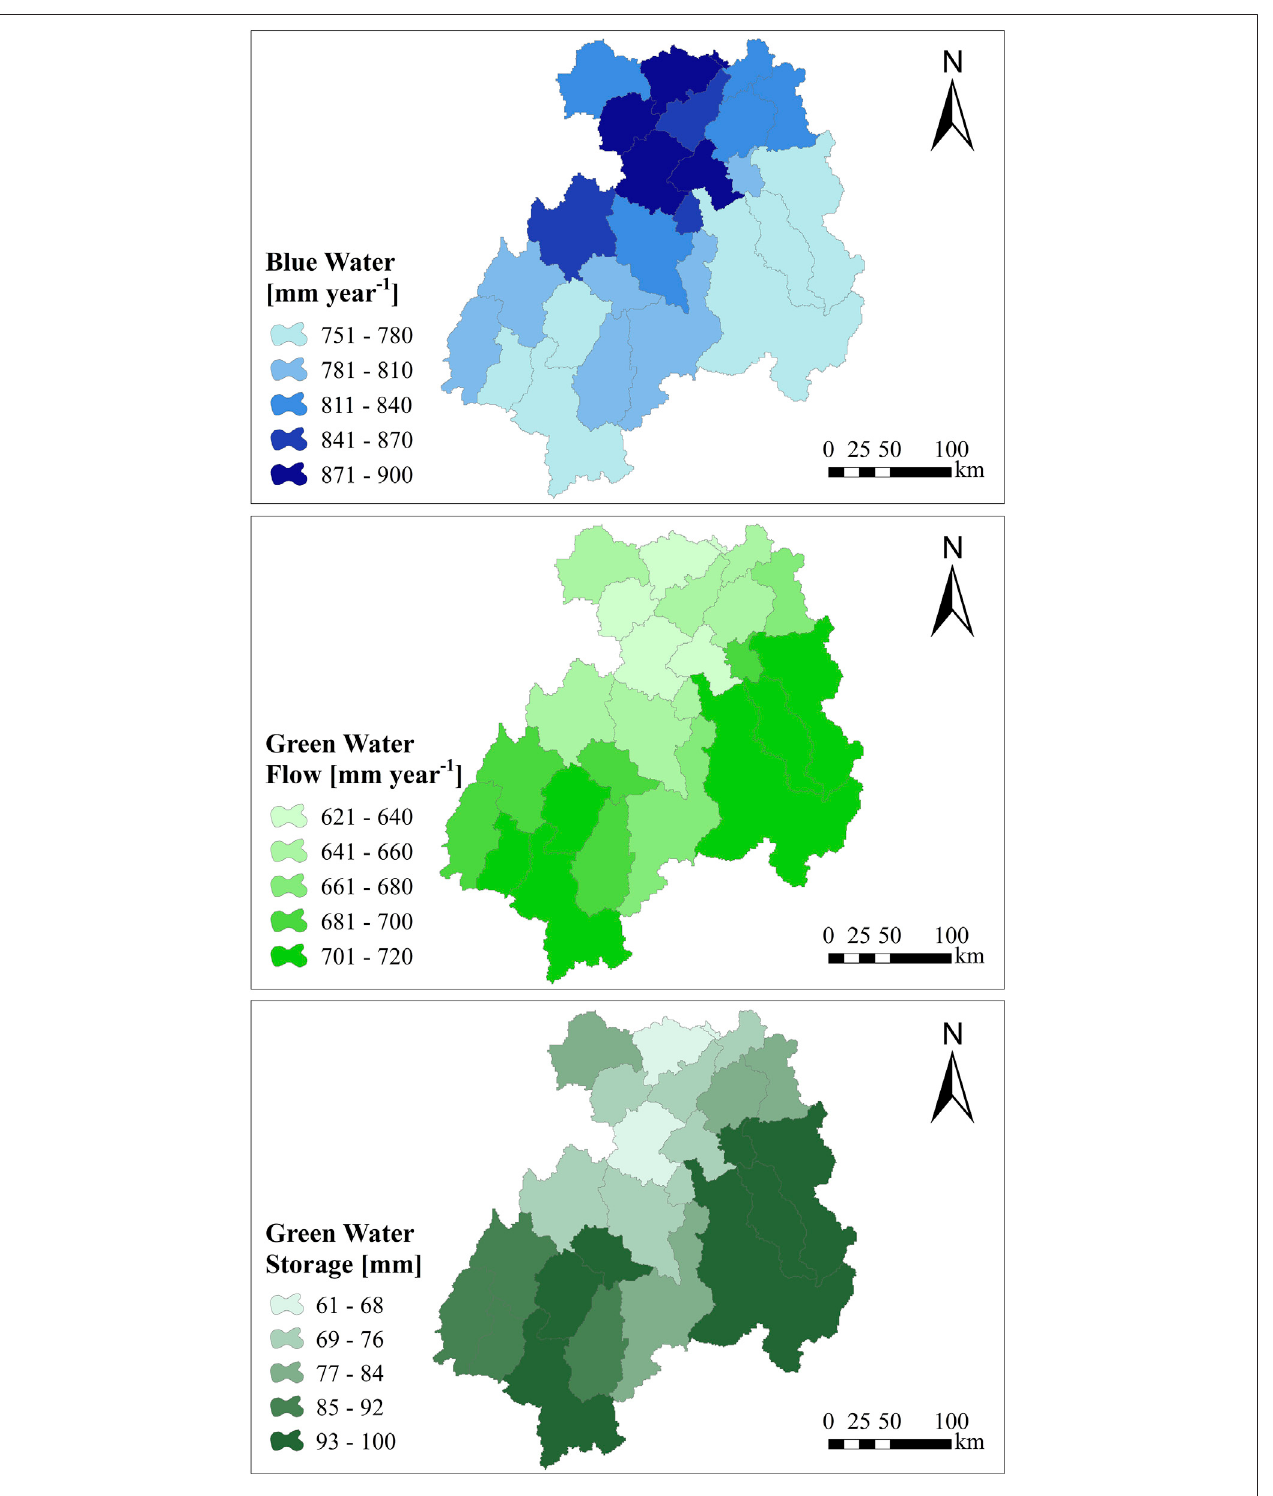
FIGURE 9 | Spatial distributions of blue and green water resources under historical scenario A (1996 – 2015) in the Xiangjiang River Basin.